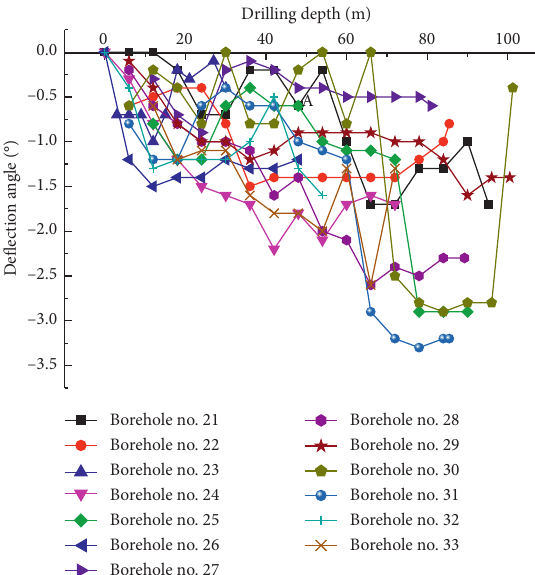
Figure 4: Change in the dip angle when the angle of encountered layer is less than the critical value.